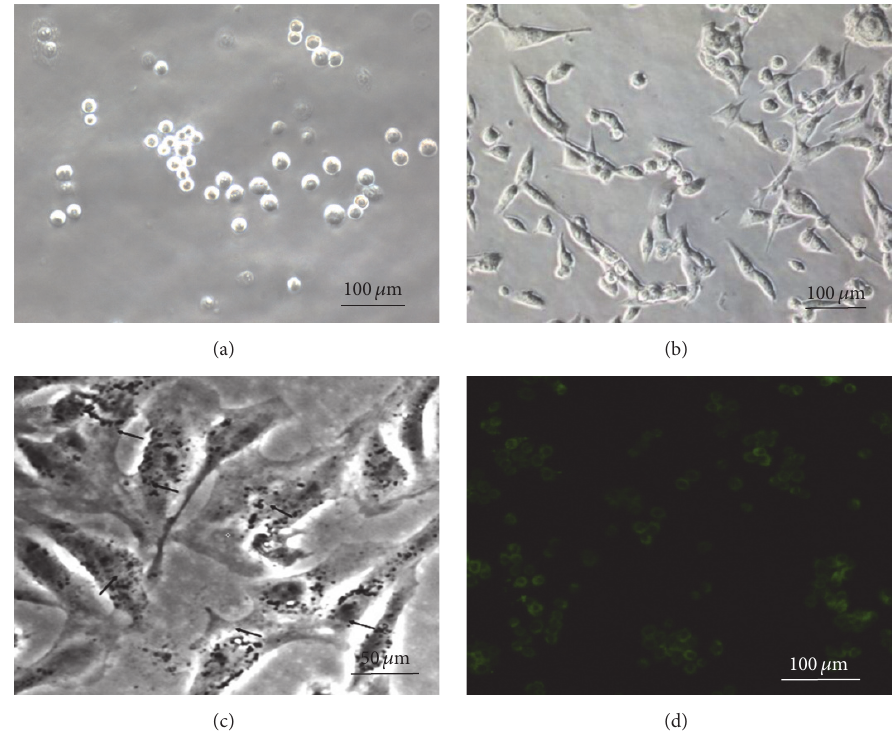
Figure 1: Kupffer cells isolation and identification. Kupffer cells were isolated from mouse liver; representative images of the morphology were shown at the initial (a) and after 12h incubation (b). To further identify the Kupffer cells, the phagocytosis ability and marker were detected. Representative images of the ink engulfment (c) and F4/80 fluorescent staining (d) were shown.